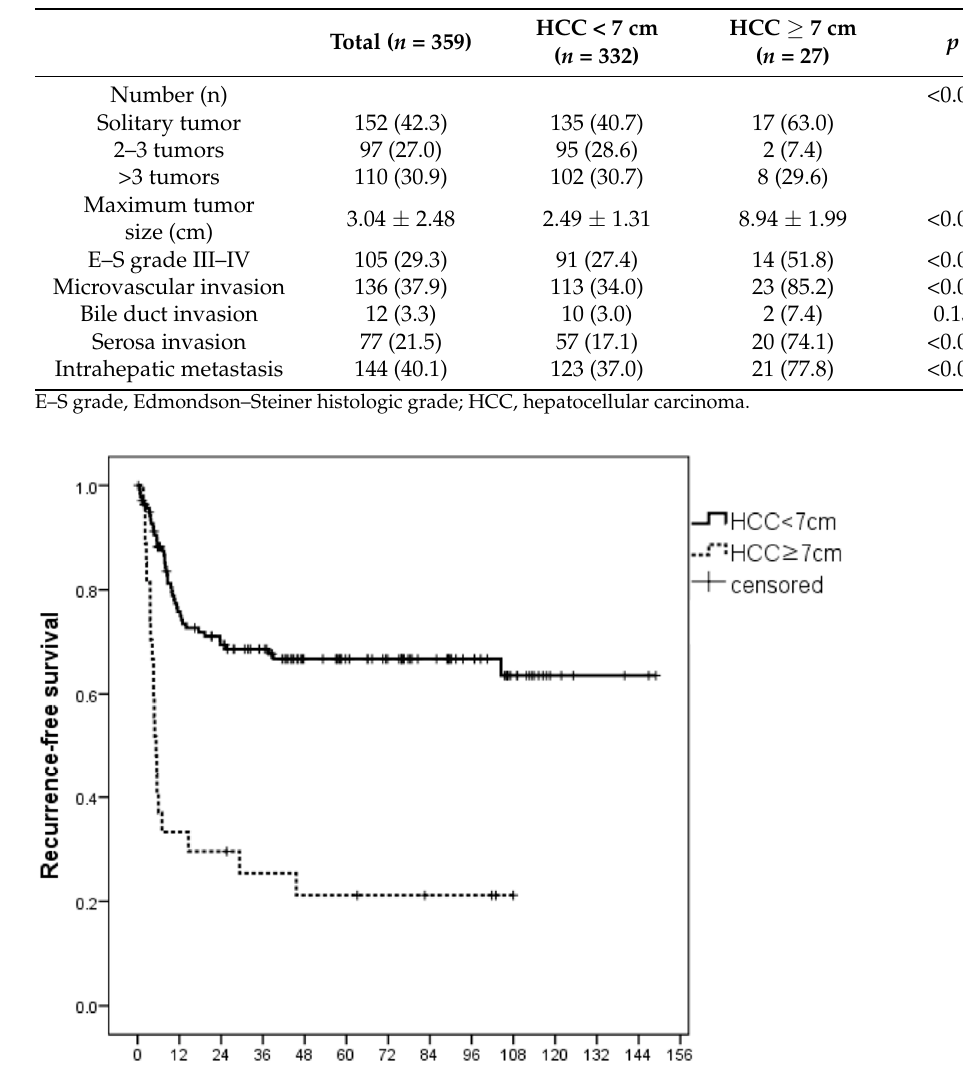
Table 6. Comparison of pathologic findings of explant liver according to HCC maximum tumor size (=7 cm).